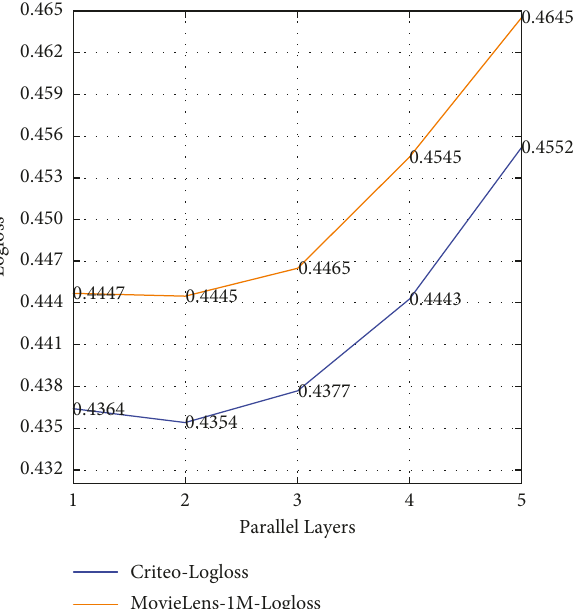
Figure 10: The parallel layers of Logloss in model CCPIN.